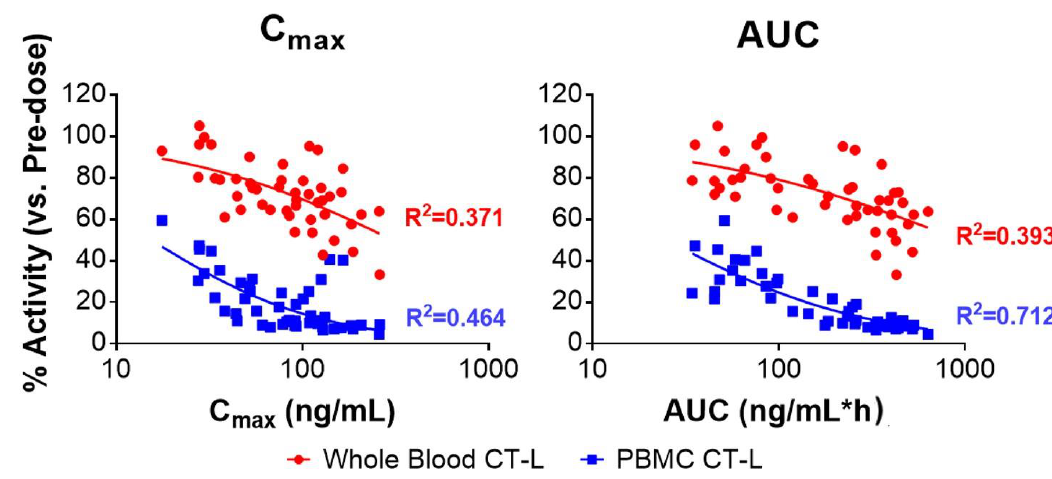
Figure 5. Immunoproteasome inhibition related to total (AUC) exposure, rather than maximum (C max )